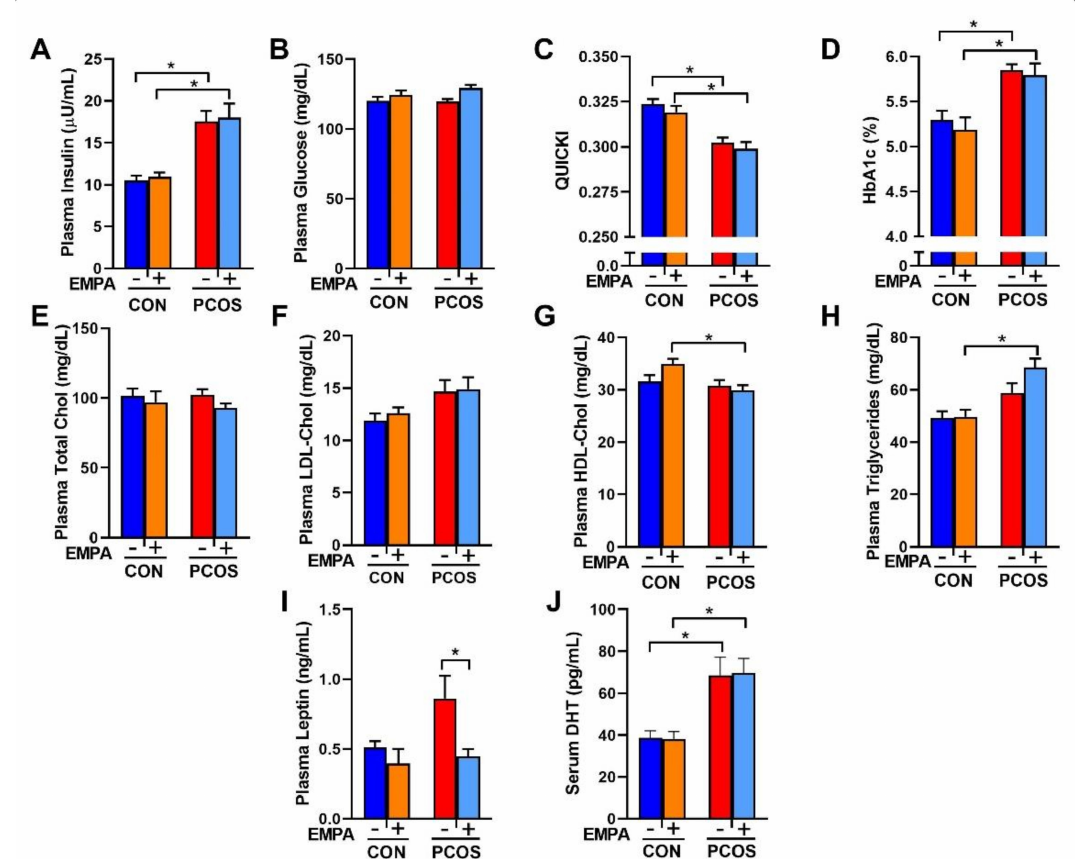
Figure 3. Effect of EMPA on metabolic parameters in PCOS. ( A – C ) Effect of EMPA on ( A ) fasting plasma insulin, ( B ) fasting plasma glucose, and ( C ) insulin sensitivity (QUICKI). ( D – H ) Effect of EMPA on ( D ) hemoglobin A1c (HbA1c), ( E ) fasting plasma total cholesterol, ( F ) fasting plasma low-density lipoprotein cholesterol (LDL-Chol), ( G ) fasting plasma high-density lipoprotein cholesterol (HDL-Chol), ( H ) fasting plasma triglycerides, ( I ) plasma leptin, and ( J ) serum DHT. Data are expressed as mean ± SEM. Data were analyzed by two-way ANOVA followed by Tukey post-hoc tests. Significant interaction was observed only for HDL-Chol. * p < 0.05. n = 7–10 per